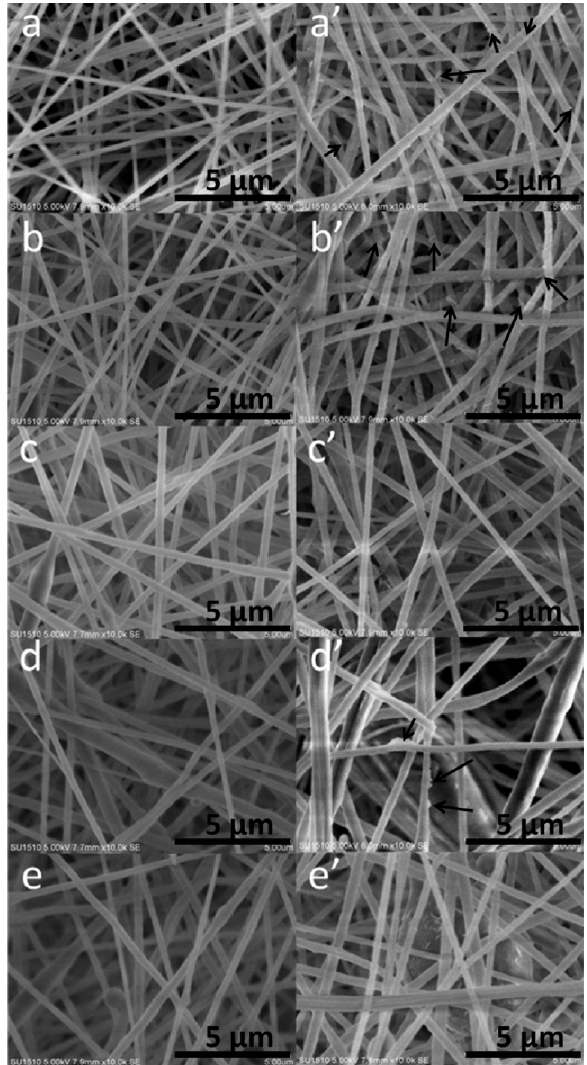
Figure 2. SEM images of PAN, PAN/MMT, PAN/MMT-GO composite nanofibers before and after enzyme immobilization: ( a and a’ ) 0 wt. % MMT; ( b and b’ ) 5 wt. % MMT; ( c and c’ ) 5 wt. % MMT/GO, MMT:GO = 9:1; ( d and d’ ) 5 wt. % MMT/GO, MMT:GO = 8:2; ( e and e’ ) 5 wt. % MMT/GO, MMT:GO =